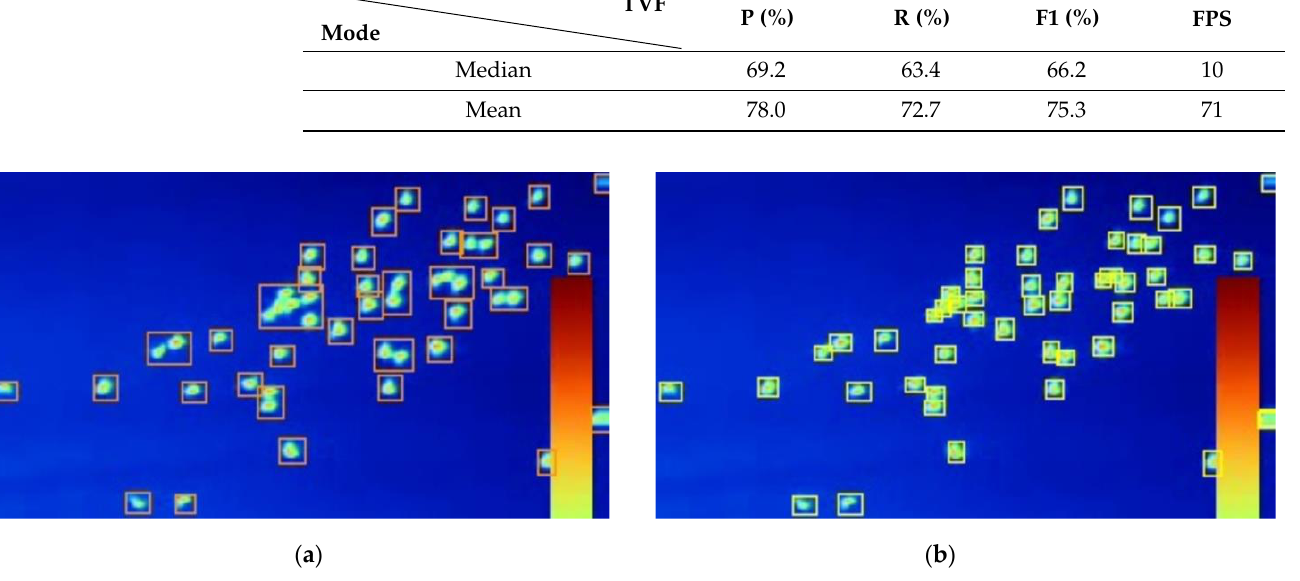
Figure 8. Comparison of the first-stage and the second-stage detection results on our dataset, ( a ) the detection result of TVF; ( b ) the detection result of GHPNet combined with TVF.